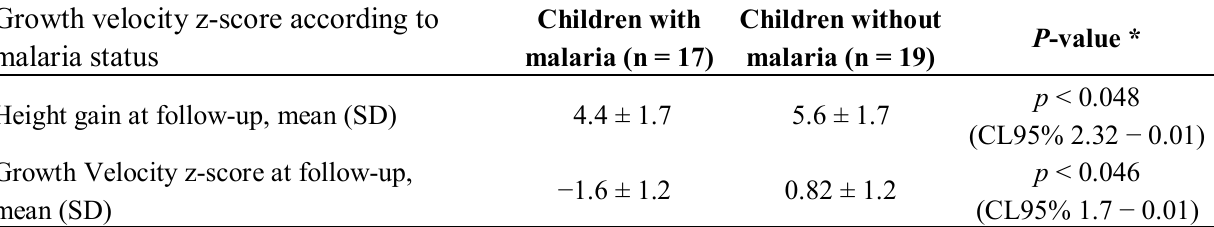
Table 3. Growth velocity z-score according to malaria status.